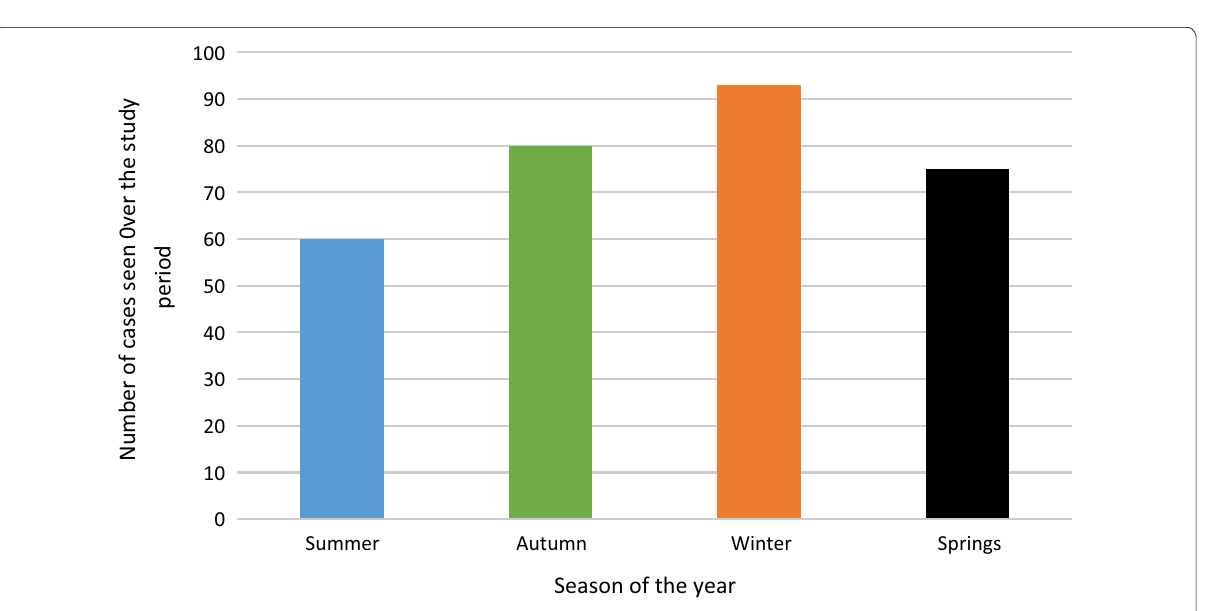
*SD (standard deviation), OR (odds ratio), CI (confidence interval)